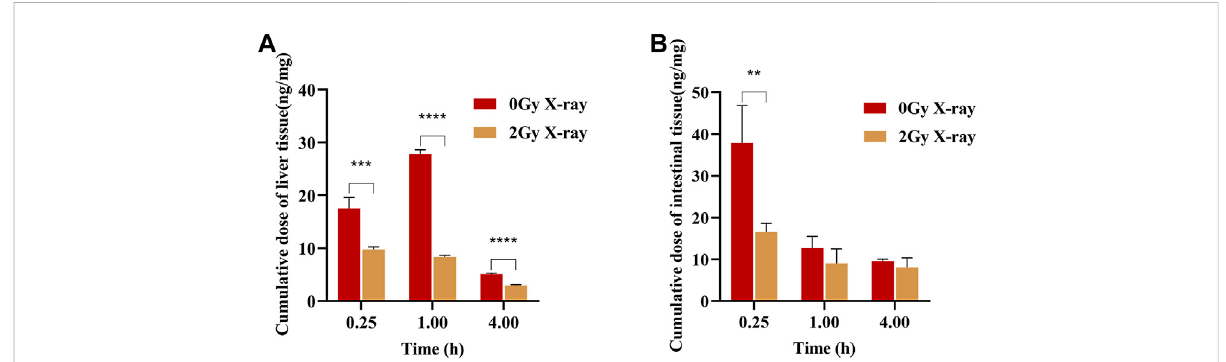
FIGURE 3 Apatinib accumulation in liver (A) and small intestine (B) at 0.25, 1, 4 h after intragastric administration presence or absence abdominal X-ray irradiation 45 mg/kg (Mean ± SD, n = 4). The t -test was used for data analysis between the two groups. ** signi fi cantly different from the absence